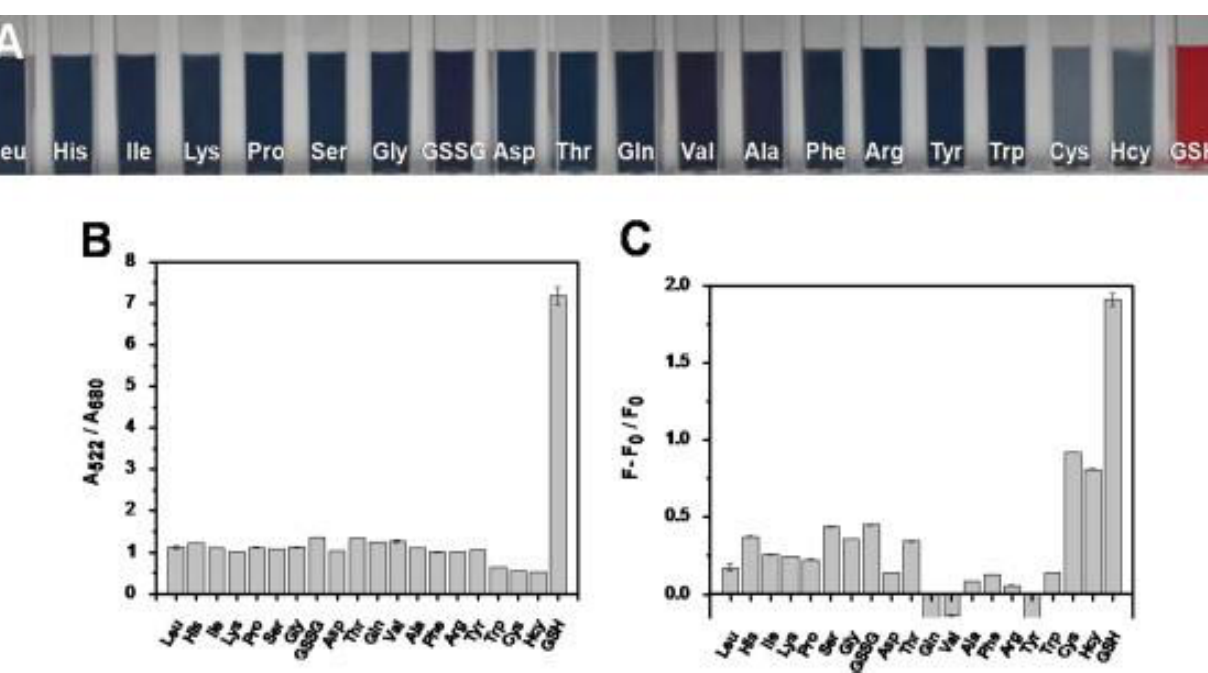
Figure 11. ( A ) Photographic images of solution containing Au NPs, CQDs, and various interferent molecules. ( B ) Absorption ratio A 522 /A 660 of solution containing Au NPs, CQDs, and various interferent molecules. ( C ) Fluorescence recovery of solution containing Au NPs, CQDs, and various interferent molecules, where F 0 represents the fluorescence intensity of the mixture of Au NPs and CQDs, and F is the fluorescence intensity of the mixture plus inspected species (( A – C ) is reproduced with the permission from Ref. [137]).